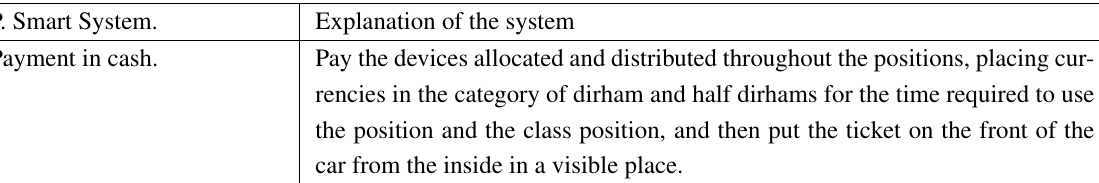
Table 6. Smart Payment Systems For smart parking in Dubai. (RTA,